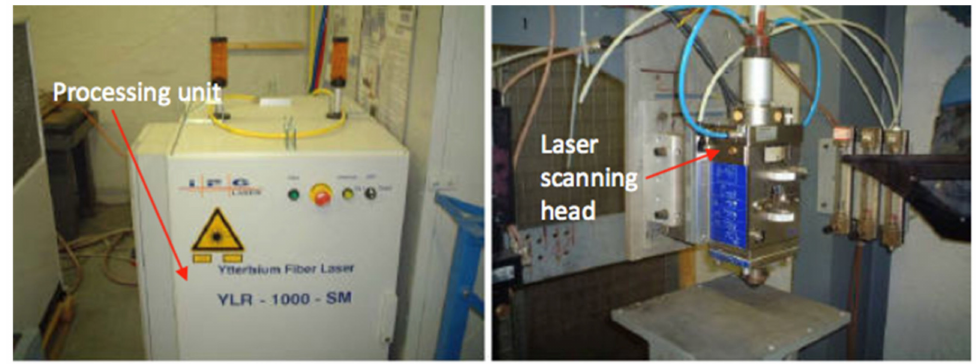
Figure 2. An IPG single-mode YLR-1000-SM 1 kW fibre laser